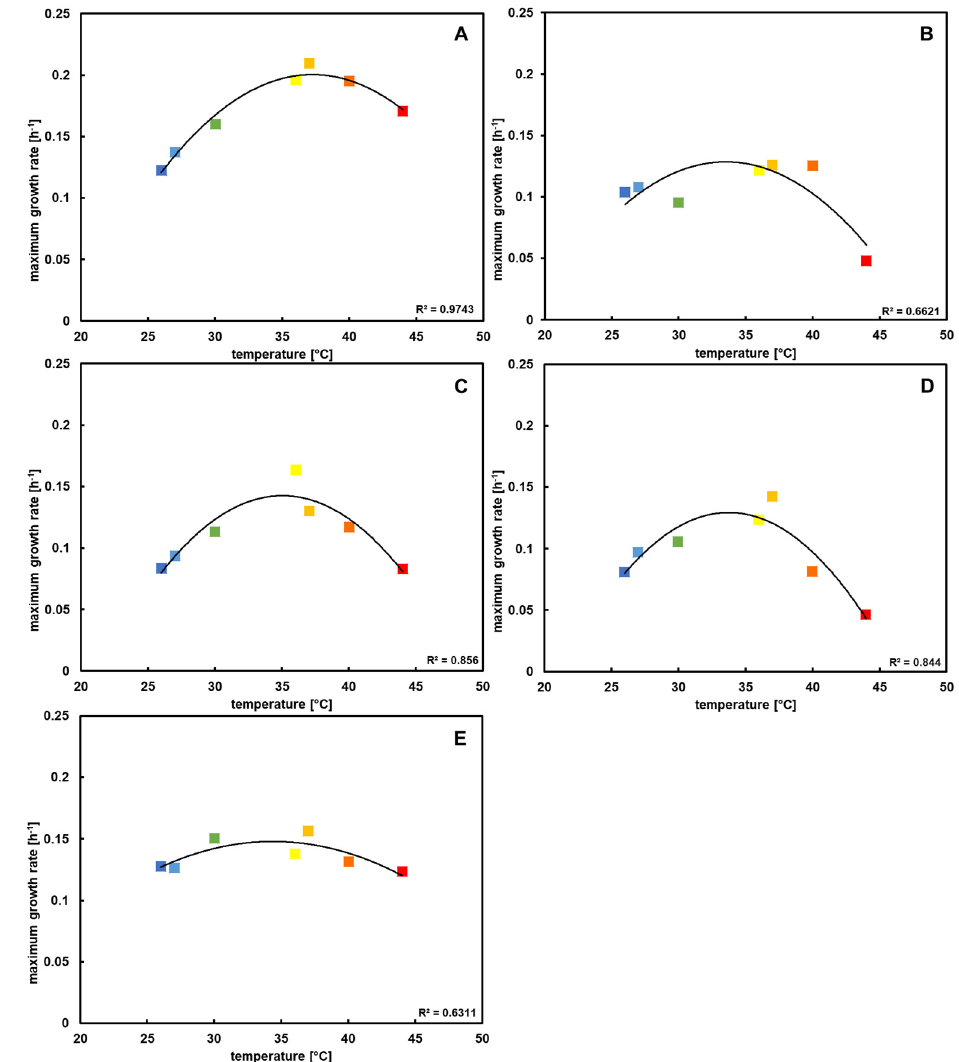
Figure 2. Maximum growth rates retrieved from the temperature block experiment after Kunze, Lattermann [34] plotted against growth temperature. All datasets correspond to a polynomal curve, with each maximum around mesophilic temperatures. ( A ) DSM 2944 T , ( B ) DSM 11072, ( C ) DSM 11073, ( D ) DSM 11104, and ( E ) DSM 65. The colors of the squares indicate the growth